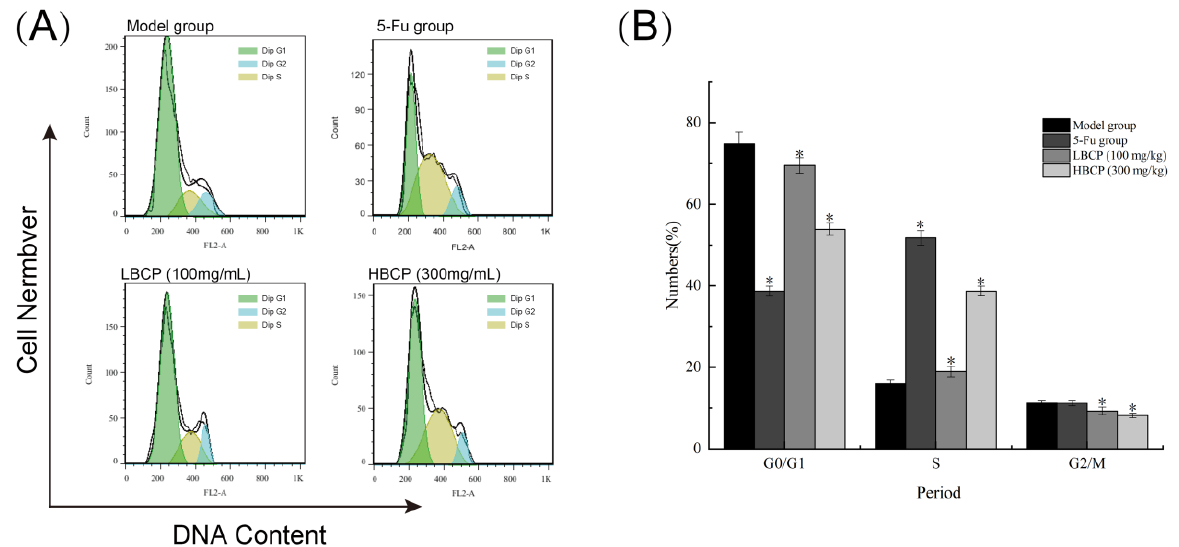
Figure 13. ( A ) Cell cycle distribution of H22 solid tumor cells in mice of different groups; ( B ) Bar graph of the cell population of the corresponding cell cycle phase (G0/G1, S, and G2/M phases). * p < 0.05 indicated significant compared to model group.